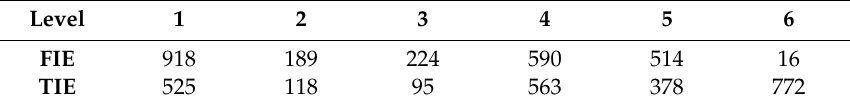
Table 4. Number of grids with di ff erent levels of FIE and